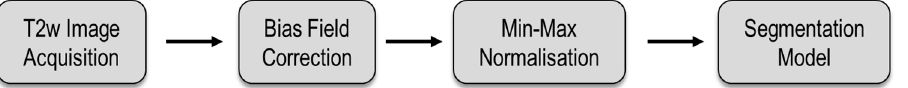
Figure 1. The image pre-processing for T2-weighted images. After acquisition, bias field correction was applied using the N4 algorithm to correct for the magnetic field inhomogeneity. The images were then normalized using the min–max approach before entering the segmentation network.